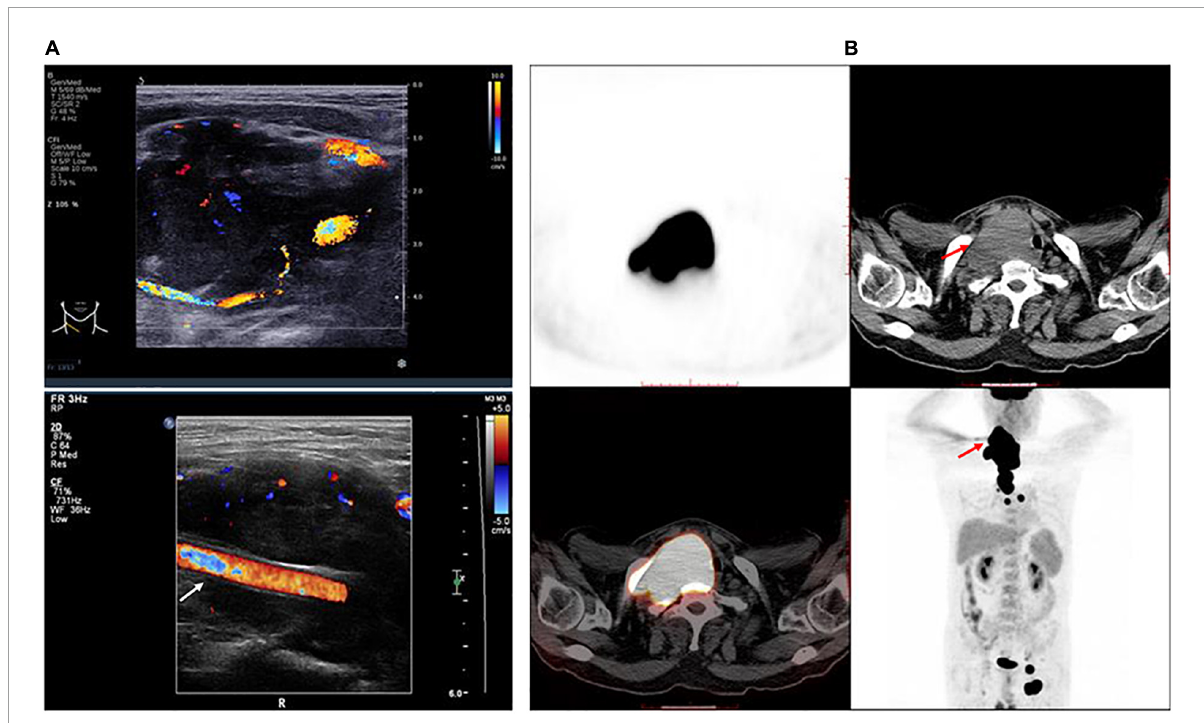
FIGURE1 Features of the tumor. (A) Right neck ultrasonography shows a hypo-echoic region with abundant blood flow surrounding the right common carotid artery, which has normal internal blood flow. White arrow indicates the right common carotid artery. (B) The trunk positron emission tomography/computed tomography shows a large mass in the right neck surrounding the adjacent large vessels, which had a non-uniform increase in radioactive uptake. Red arrow indicates the tumor.